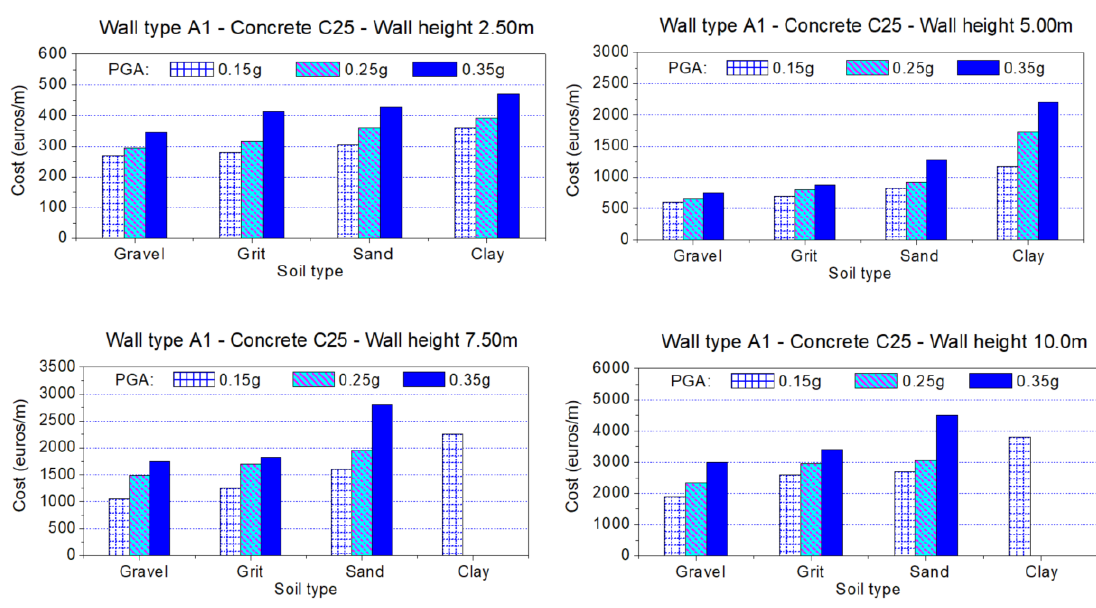
Figure 4. Cost of retaining walls type A1 made by reinforced concrete C25.